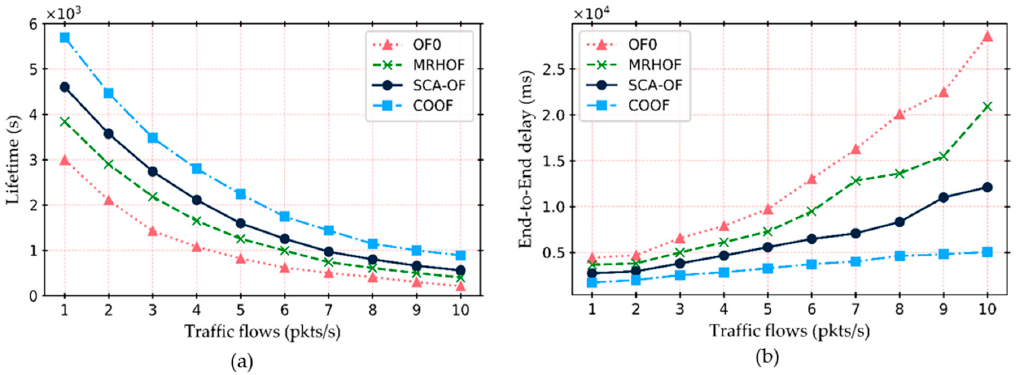
Figure 15. The impact of the traffic load variation: ( a ) network lifetime with respect to different traffic flows, and ( b ) end-to-end delay in millisecond with respect to different traffic flows.